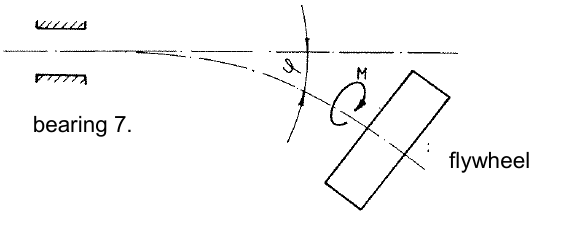
Figure 16 – Deformations of the main sleeve on the 7th bearing of the engine